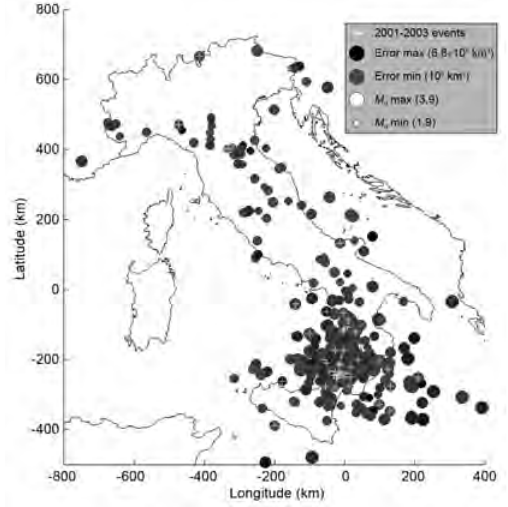
Fig. 13e. Largest errors (above 1000 km 3 ) distribu- tion. The radius of the circumferences is related to M d value, the color changes with the error values and, in the end, the plus sign indicates the events which occurred in the last three years (see the legend as reference).